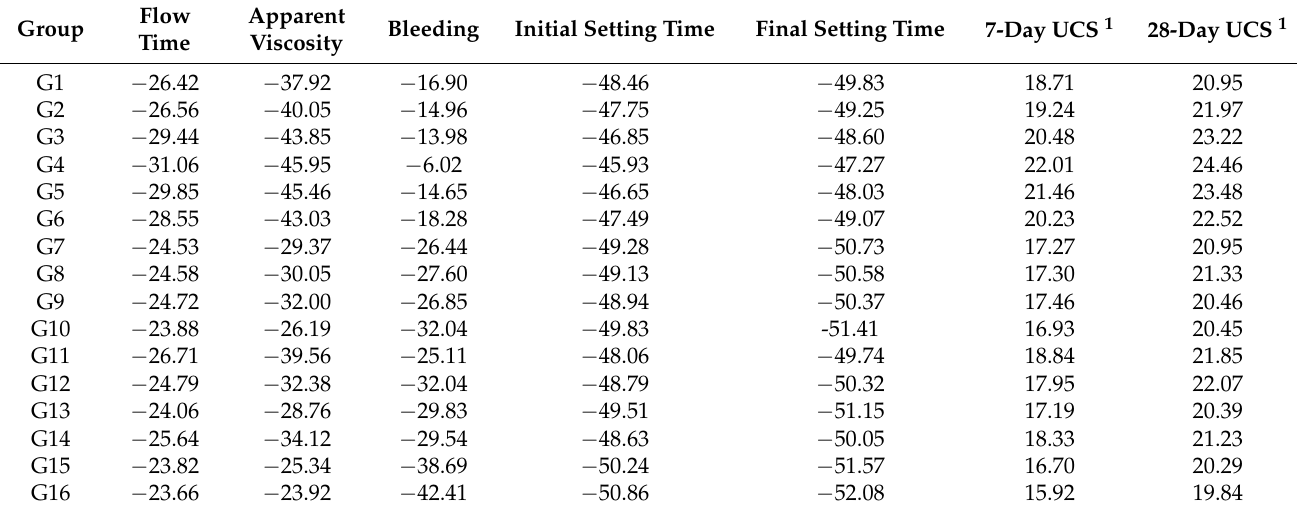
Table 7. S/N ratio values of properties of the UC-based slurry.